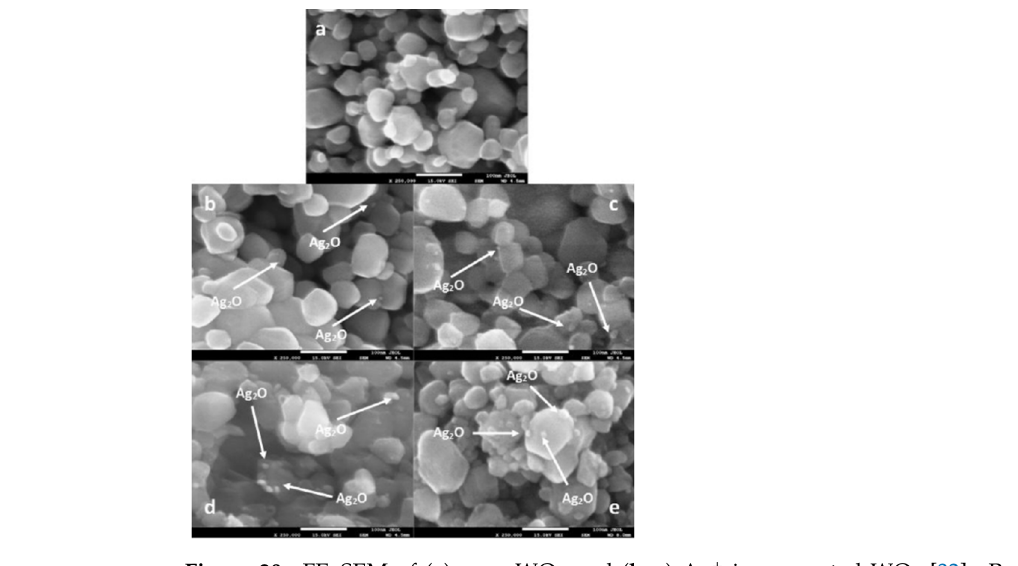
Figure 20. FE–SEM of ( a ) pure WO 3 and ( b – e ) Ag + impregnated WO 3 [32]. Reproduced with permission from Hameed et al. Copyright © 2022 Elsevier.